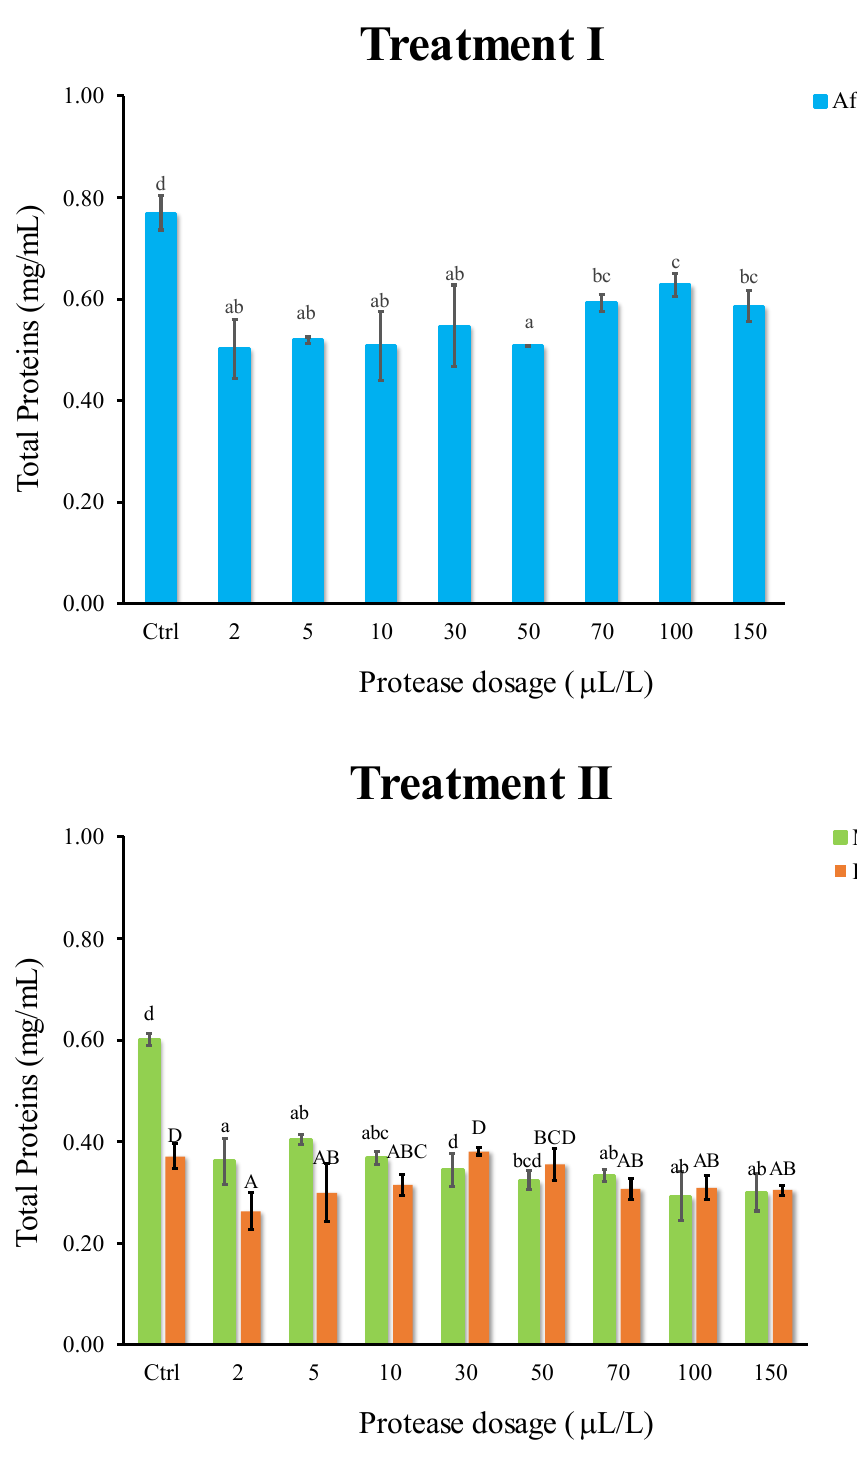
Figure 5. Total proteins (mg/mL) of white must wine subjected to enzymatic addition (protease in the range of 2–150 µ L/L) after ( a ) Treatment I (cold settling prior to AF) and ( b ) Treatment II (at yeast inoculum). Ctrl is clarified must with the only pectinolytic enzyme. For each sample, means with different roman letters are significantly different ( p ≤